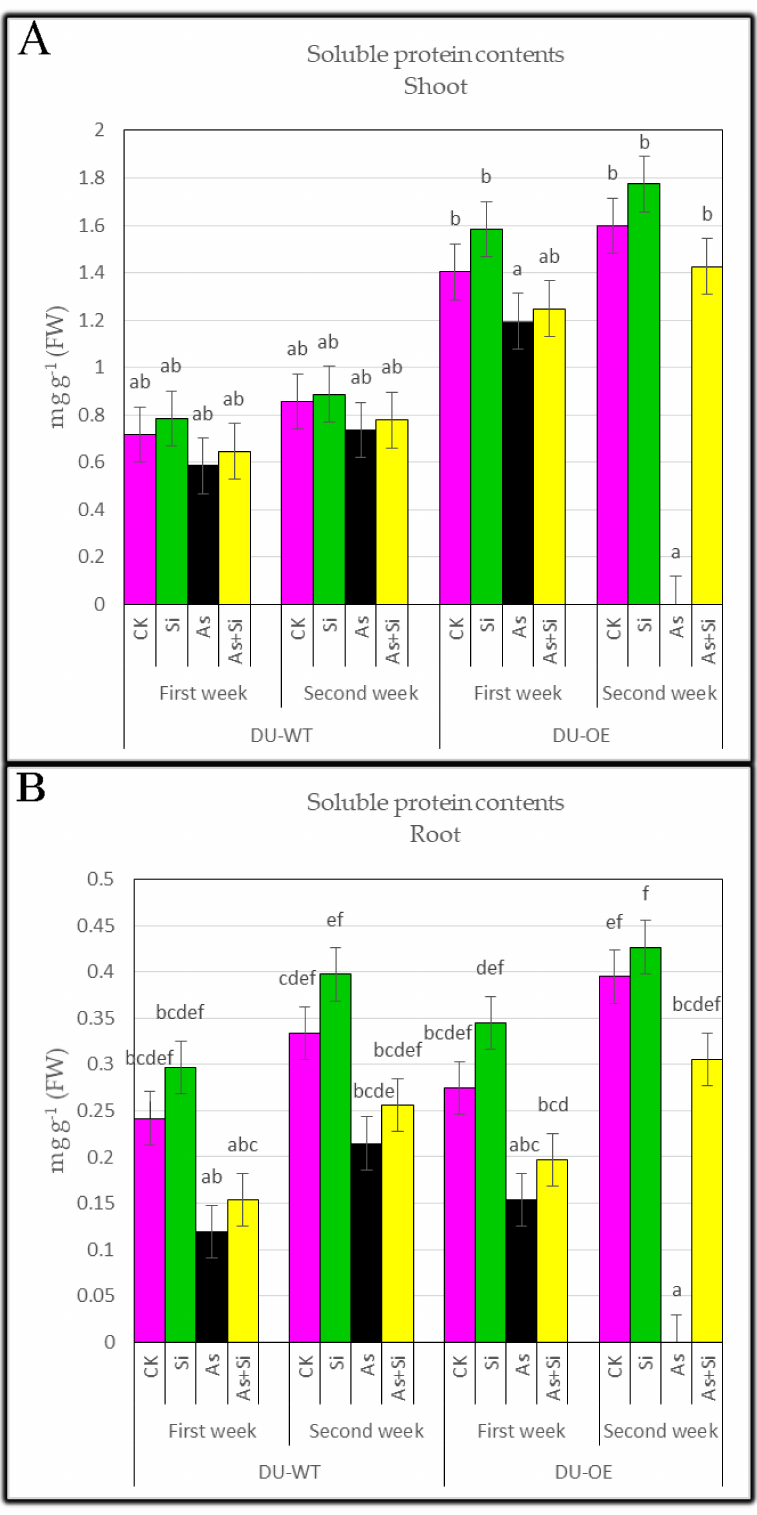
Figure 4. Soluble protein contents of DU-WT and DU-OE shoots, the first and second weeks after adding treatments ( A ); soluble protein contents of DU-WT and DU-OE roots, the first and second weeks after adding treatments ( B ). The different letters on the bars indicate a significant difference among independent treatment ( p ≤ 0.05); (FW: fresh weight; CK: control; Si: 0.70 mM Si; As: 30 µ M As; As+Si: 30 µ M As + 0.70 mM